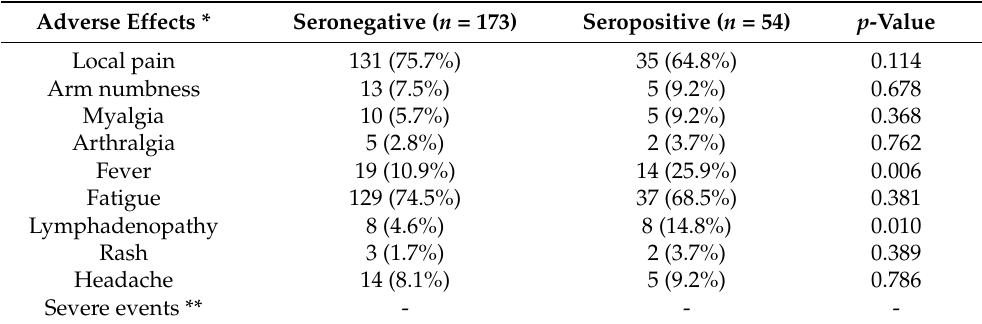
Table 2. Comparison of seronegative vs. seropositive pregnant patients’ adverse effects after receiving the COVID-19